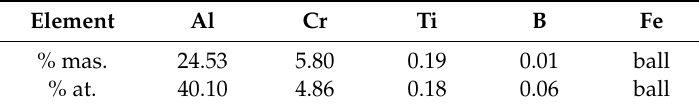
Table 1. Chemical composition of Fe40Al5Cr0.2TiB alloy.